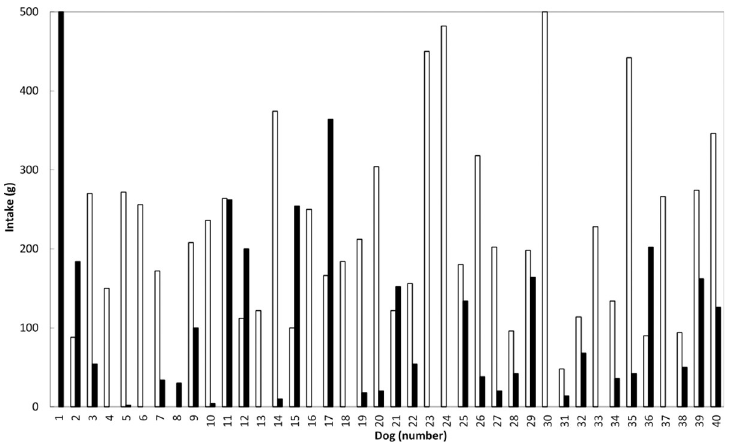
Fig 1. Summarized food intake of the two diets [MDM = Mechanically Deboned Chicken Meat (black columns) and MBP = Meat By-Products (white columns)] for each dog ( P < 0.001).